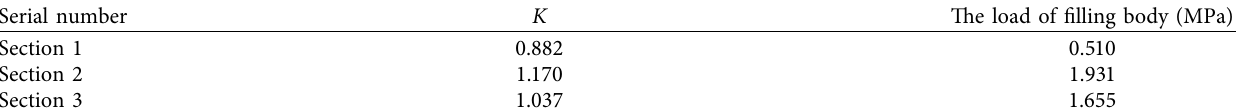
Table 1: Loading value of filling body in typical section.